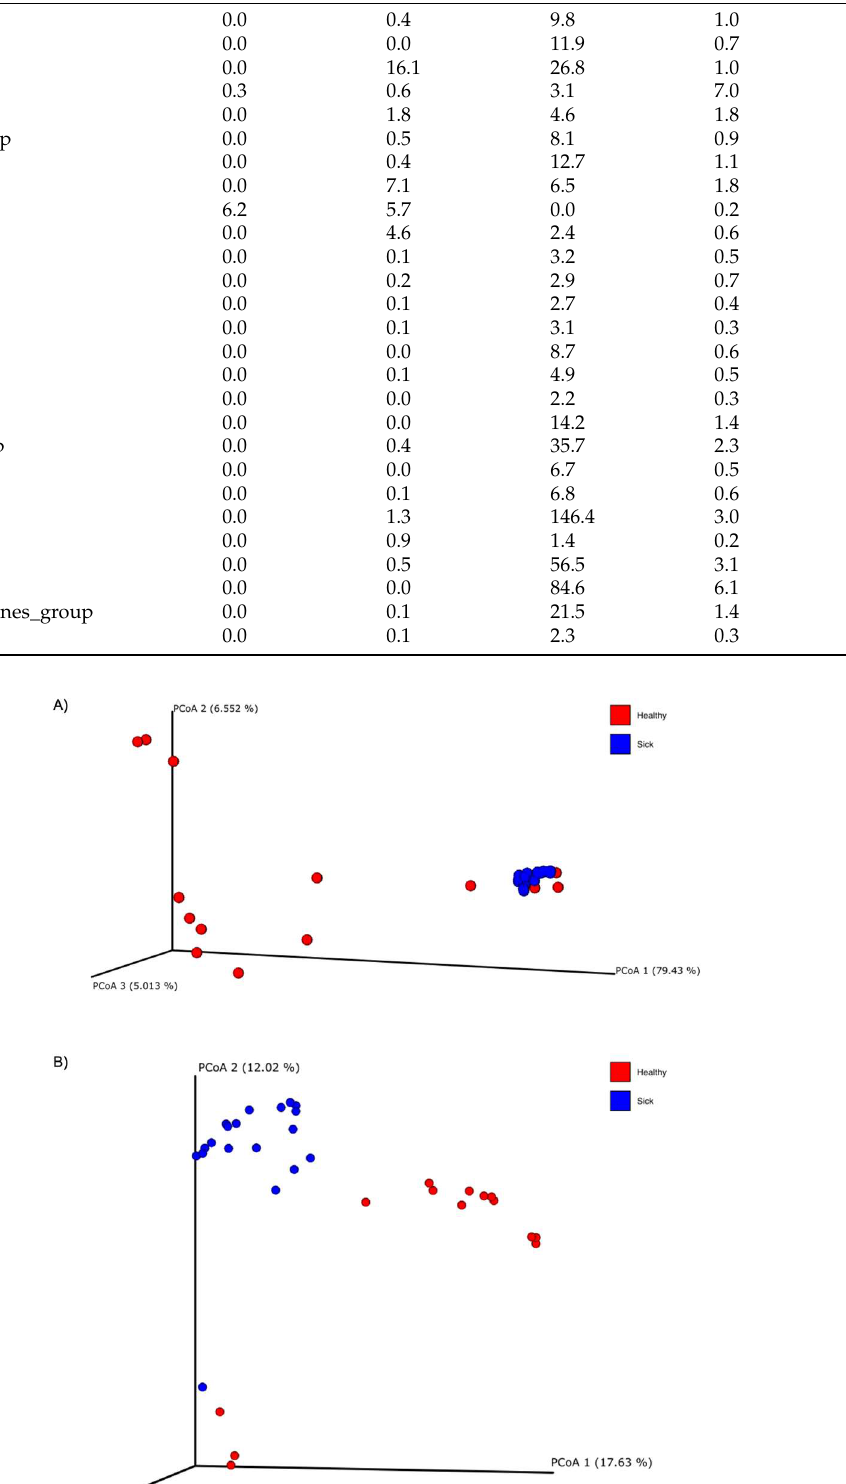
Figure 2. Alpha diversity, shown as the median of the Shannon index ( A ) and the Evenness index ( B ), in blood samples of healthy and sick dogs. Table 2. Non parametric Kruskal–Wallis test of the Shannon and Evenness alpha diversity indexes and PERMANOVA analysis of the weighted and unweighted UniFrac dissimilarity matrix on the blood microbiome of healthy and sick dogs. p -value below 0.05 denoted significance.